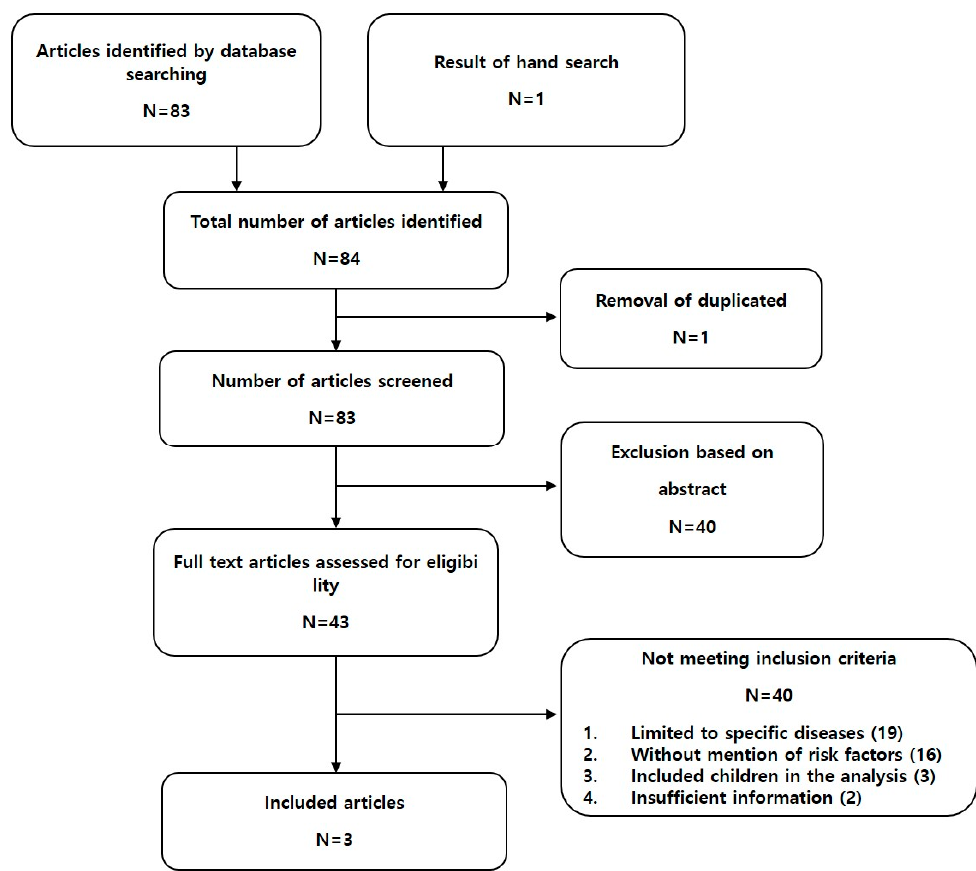
Figure 2. Preferred reporting items for systematic reviews and meta ‐ analyses